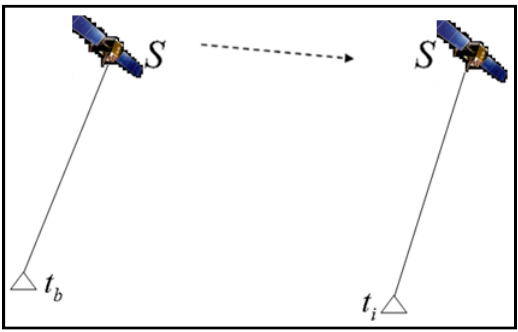
Figure 1. Principle of time-relative method.